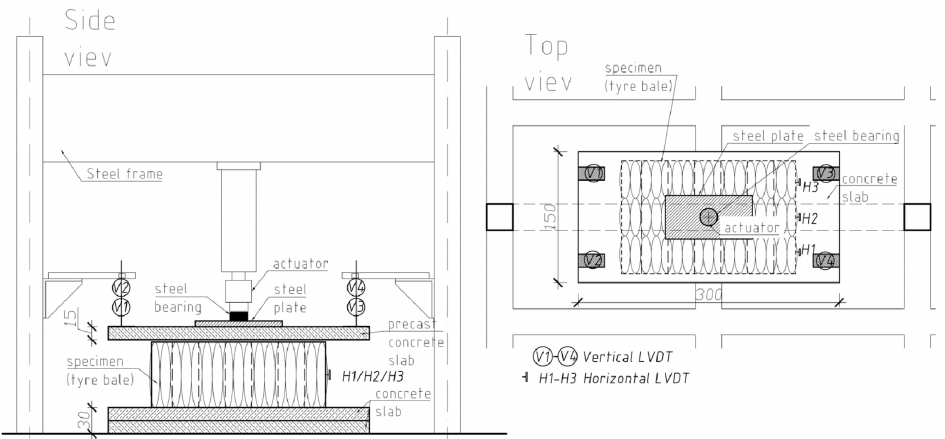
Figure 6. Compression test